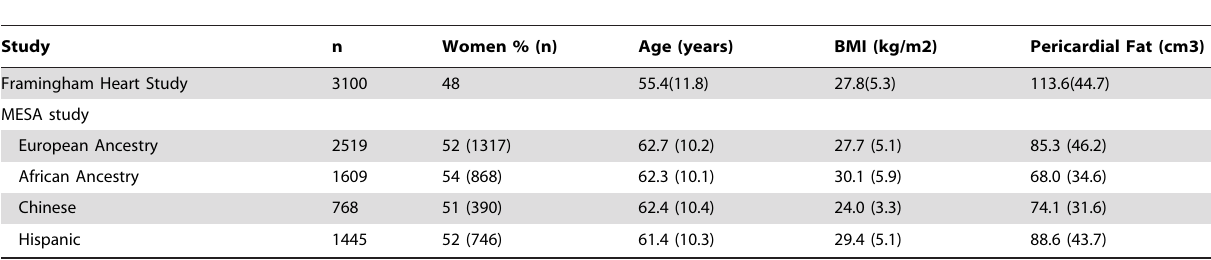
Table 1. Study sample